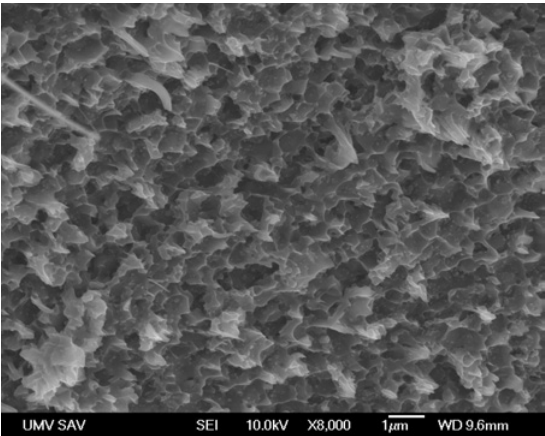
Figure 16. The fracture of Al-4 vol.% Al 4 C 3 after SP creep, direction 90°.